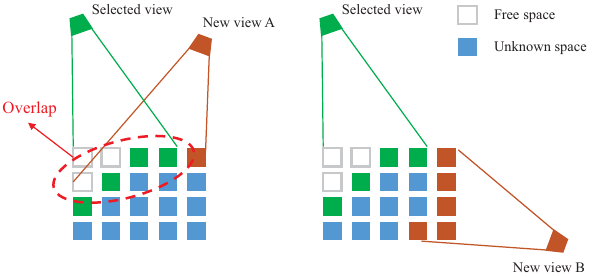
Fig. 1 Next-best view (NBV). Compared to new view A on the left, new view B on the right can collect more unknown information. It is thus more useful as the